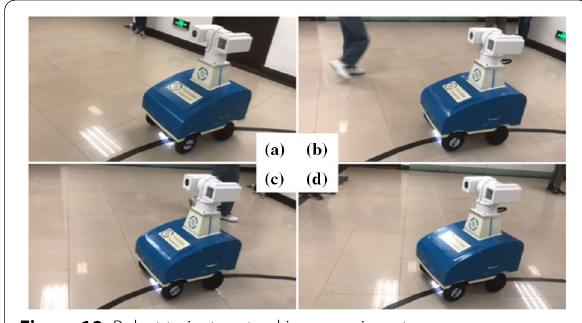
Figure 19 Robot trajectory tracking experiment